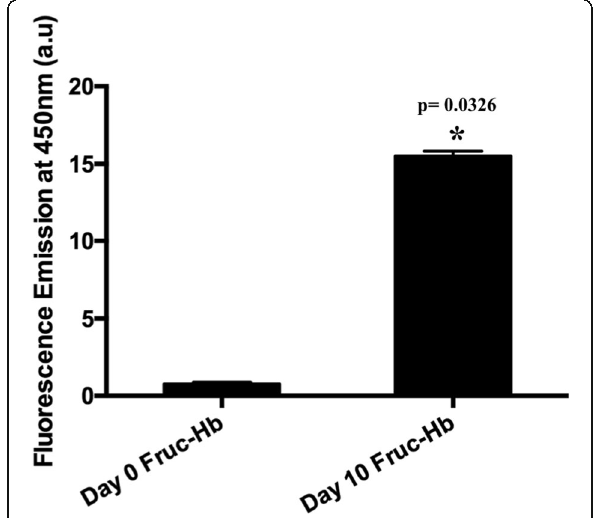
Fig. 1 Formation of AGEs measured by generation of fluorescence at 450 nm when haemoglobin is incubated with fructose for 10 days. Comparison of 450 nm fluorescence emission in day 0 Fruc-Hb and day 10